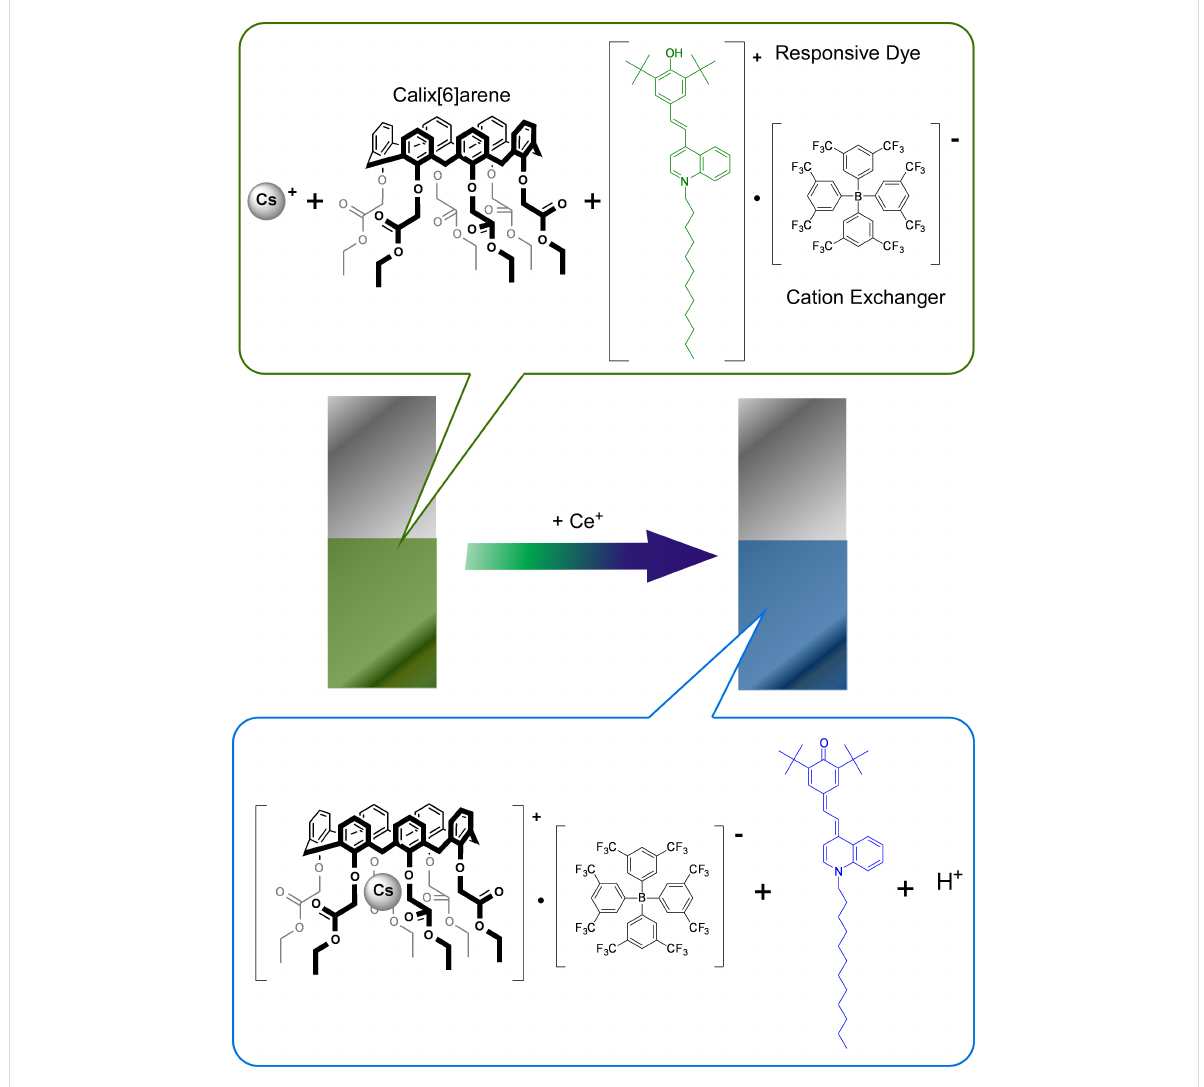
Figure 4: An optode sensor to visually detect cesium ions in domestic water and seawater, comprised of a calix[6]arene derivative, responsive dye KD-M1337, and cation exchanger.